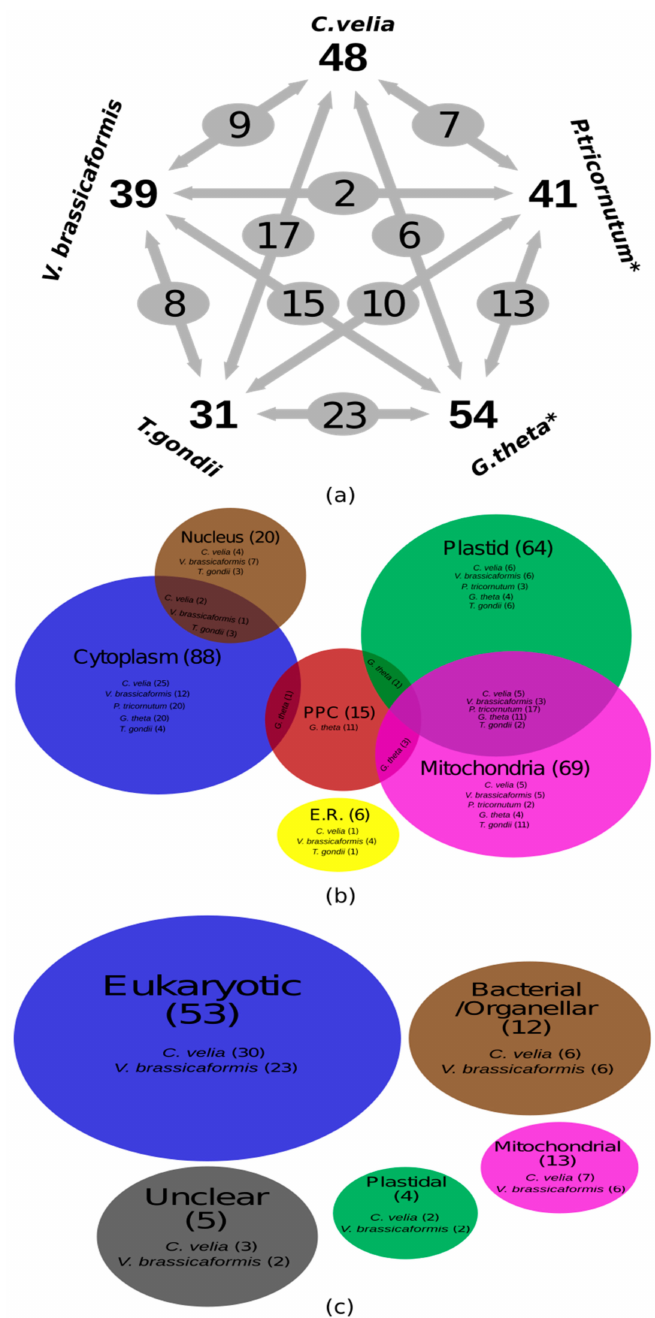
Figure 1. ( a ) Numbers of Aminoacyl-tRNA synthetases in the chromerids ( Chromera velia and Vitrella brassicaformis ), in comparison to a diatom ( Phaeodactylum tricornutum ), a cryptophyte ( Guillardia theta ), and the apicomplexan Toxoplasma gondii ; ( b ) Euler diagram representing the protein subcellular localization results of Aminoacyl-tRNA synthetases (AaRS) in the chromerids, P. tricornutum , G. theta and T. gondii ; ( c ) Euler diagram representing the evolutionary origins of the chromerid AaRSs. Alternatively, the activity of some AaRSs could be replaced by a tRNA-dependent amino acid transformation mechanism [40]. In this study, we found that both C. velia and V. brassicaformis possess two genes coding for Glutamyl-tRNA Gln amidotransferase (Glu-AdT). Both Chromera ’s